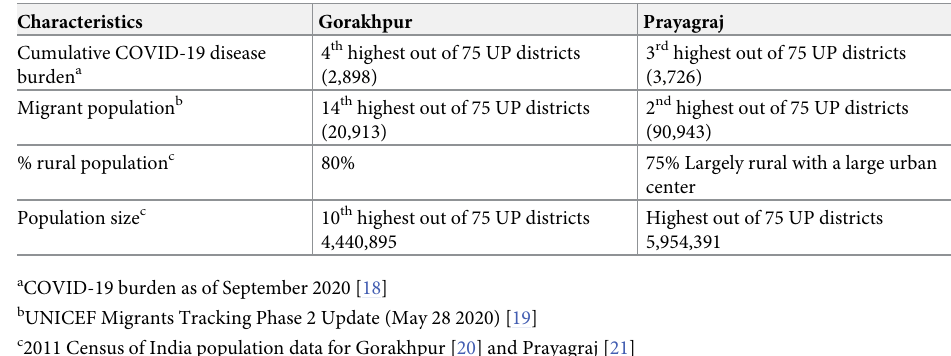
Table 1. Characteristics of embedded district cases.